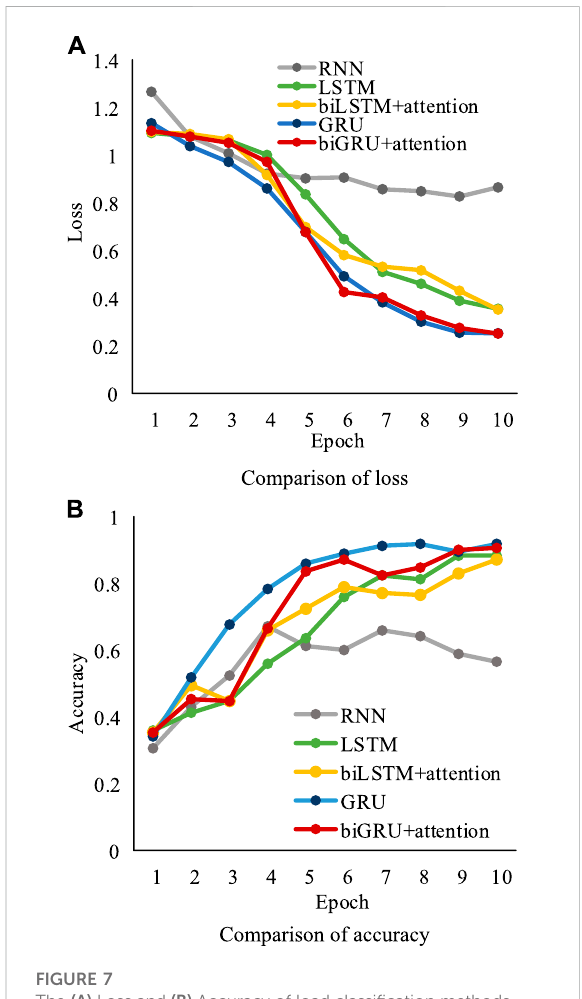
FIGURE 7 The (A) Loss and (B) Accuracy of load classi fi cation methods using the Wine dataset.